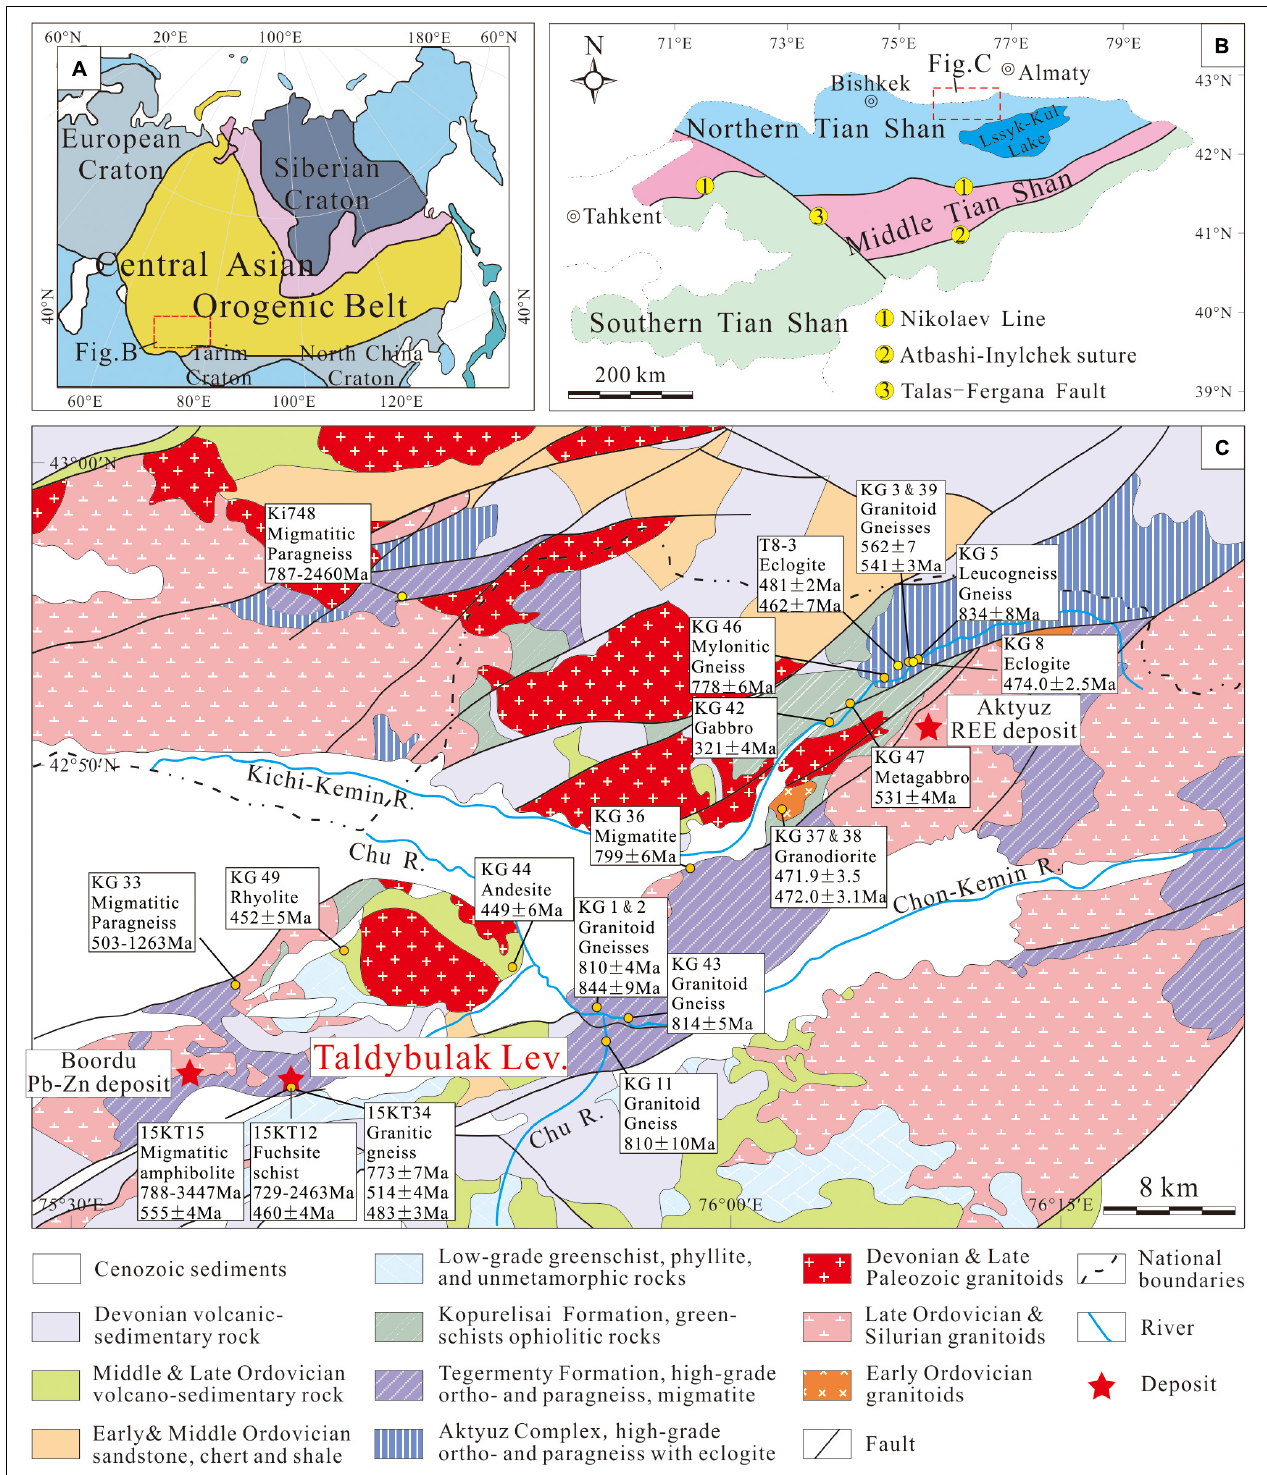
FIGURE 1 | (A) Tectonic map of Central Asian Orogenic Belt (CAOB) showing the location of the Kyrgyz Tianshan (modified from Gao et al., 2009b). (B) Sketch tectonic map of Kyrgyz Tianshan showing the locations of the Aktyuz terrane, modified from Djenchuraeva et al. (2008) and Seltmann et al. (2011). (C) Geology map of the Aktyuz metamorphic terrane where the Taldybulak Levoberezhny gold deposit is located (modified from Kröner et al., 2012). The geochronological data are from Kröner et al. (2012), Rojas-Agramonte et al. (2013, 2014), and this study.